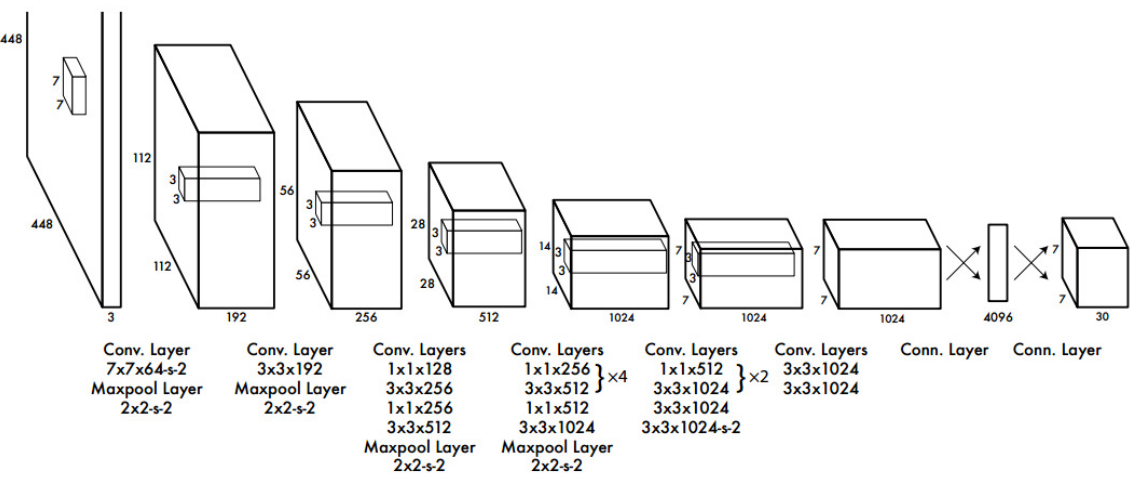
Figure 12. YOLO network structure.